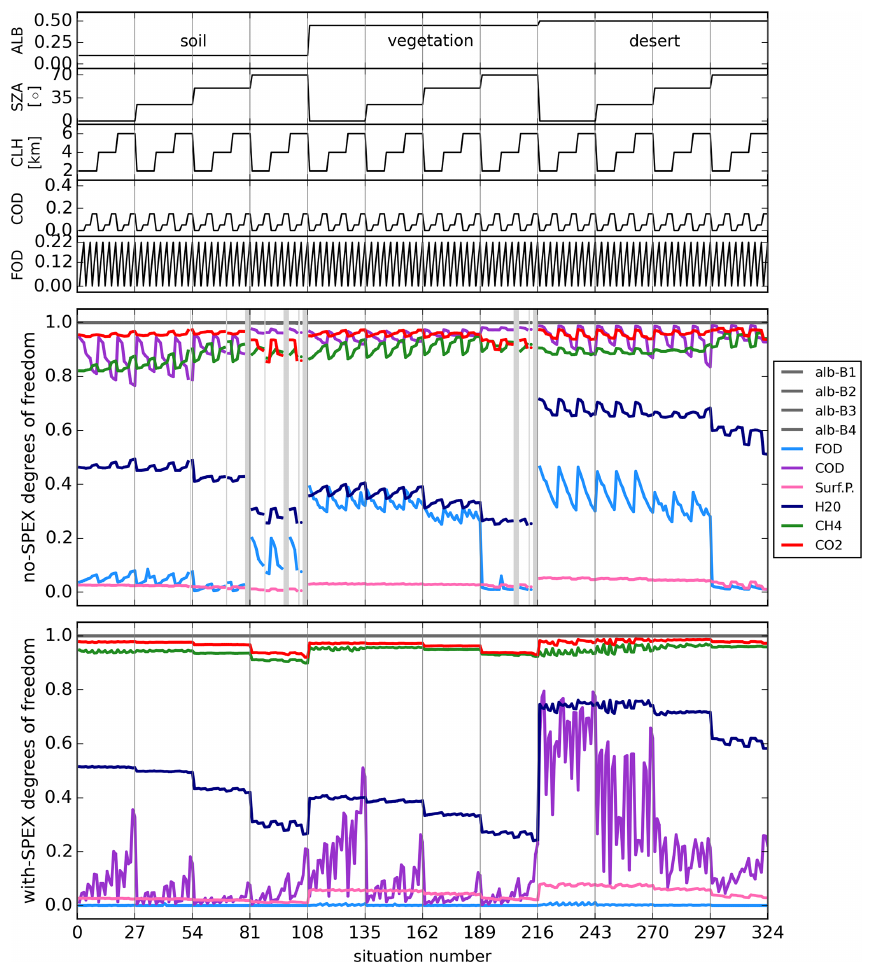
Figure 7. NanoCarb state vector variable degrees of freedom averaged over the 23 FOV pixels used to interpolate L2 results to the whole FOV. Results are plotted as a function of the situation number: the top five panels detail the ALB (0.7µm), SZA, CLH, COD and FOD values defining all 324 situations. Grey-shaded areas denote situations for which retrievals did not satisfactorily